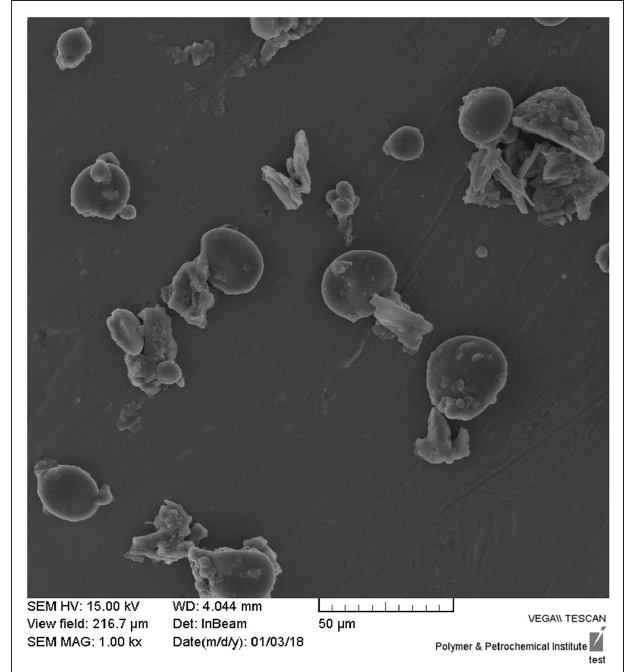
FIGURE 1 | Representative scanning electron micrographs of CNPs/ICG (scale bar represents 50 µ m).